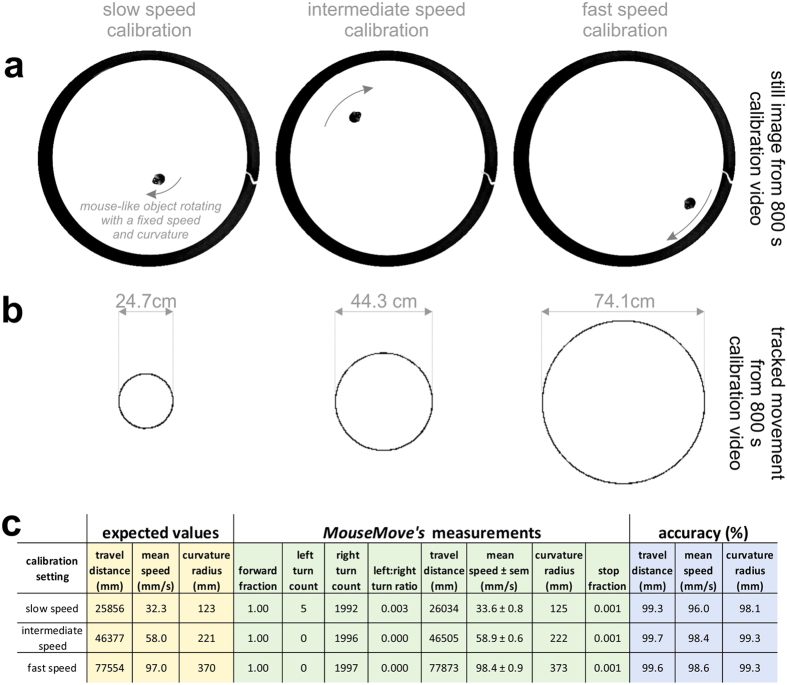
Mechanical calibration of MouseMove.(a) Video still image of a mouse-like object affixed to a perspex arm driven by a speed-controlled rotor. The clockwise rotation of the arm is indicated. The position of the mouse-like object was varied (n = 3 positions) to produce a slow, intermediate and fast circling object for tracking. (b) The corresponding cumulative x,y coordinates tracked by the preprocessing macro over the 800 s videos. The diameter of the tracked circular path for the mouse-like object is indicated. (c) The tracked x,y coordinates (from panel (b)) were fed into MouseMove’s GUI and the observed measurements (green shading), the expected values (yellow shading), and the percent accuracy between the observed versus expected measurements (blue shading) is shown.